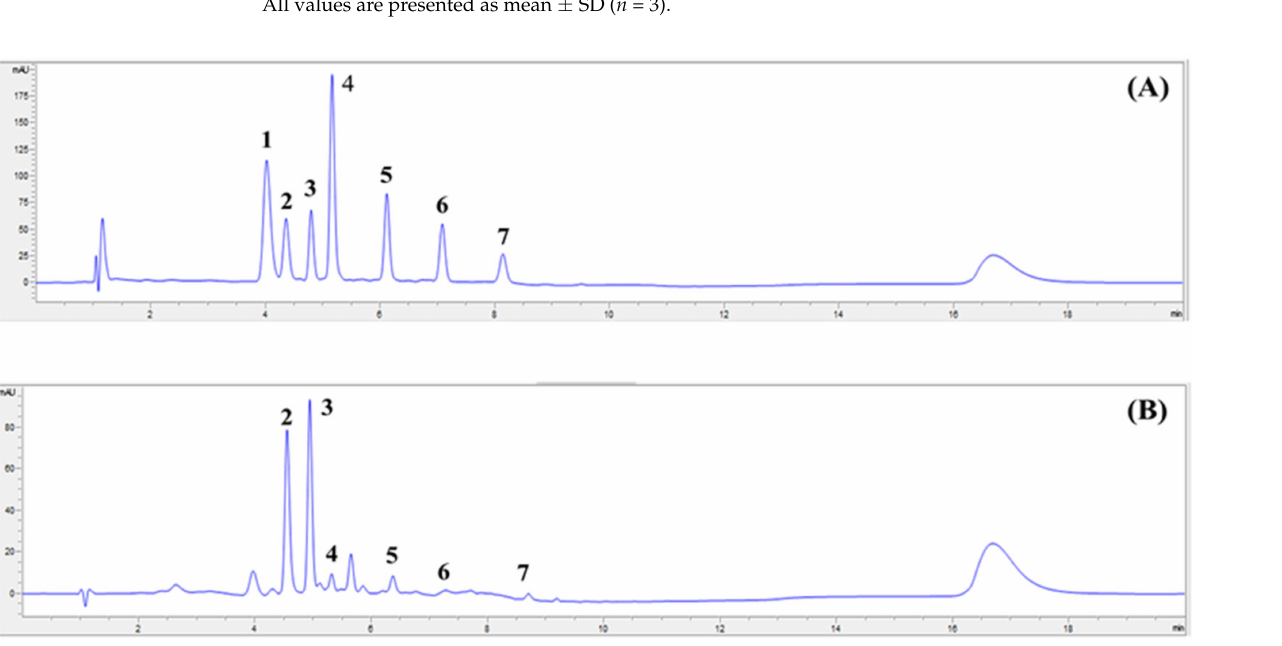
Figure 1. HPLC chromatogram of carotenoid standards ( A ) and sweet corn extract (SCE) ( B ) separated by HPLC–DAD at 450 nm. The compounds are (1) astaxanthin; (2) lutein; (3) zeaxanthin; (4) trans- β - Apo-8 (cid:48) -carotenal; (5) β -cryptoxanthin; (6) α -carotene; (7) β